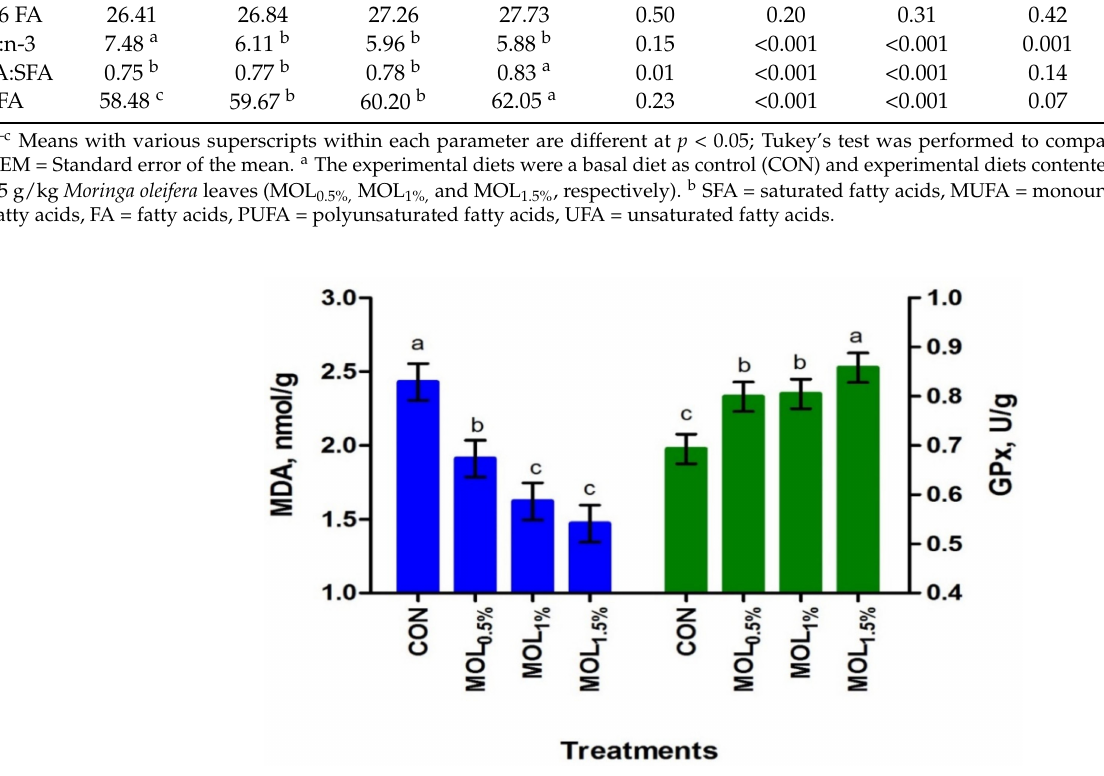
Figure 3. Meat oxidation stability of growing rabbits fed the experimental diets after storage at 4 ◦ C for 72 h. a–c Means with various letters within each parameter are different at p < 0.05. The experi- mental diets were a basal diet as control (CON) and experimental diets contented 5, 10, or 15 g/kg Moringa oleifera leaves (MOL 0.5%, MOL 1%, and MOL 1.5% , respectively). Means are presented ± SEM. MDA = malondialdehyde, GPx = glutathione